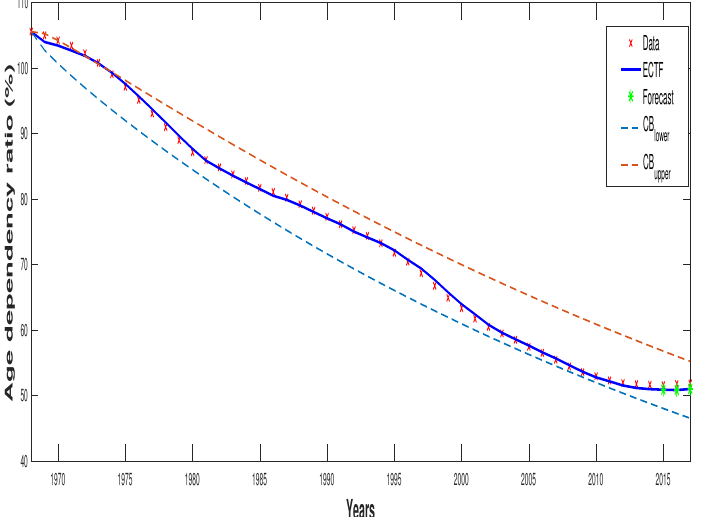
Figure 2. Observed data, estimated conditional trend function (ECTF) and the forecasted